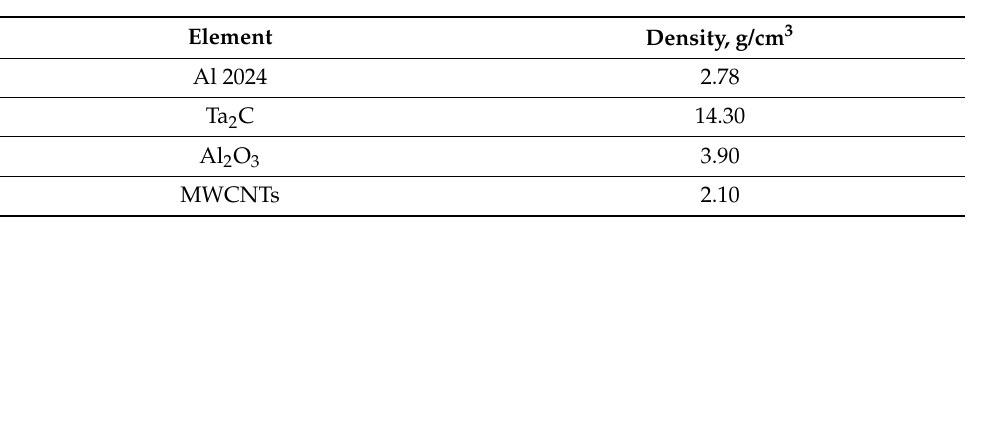
Table 2. The densities of the Al 2024 aluminum alloy and the reinforcement